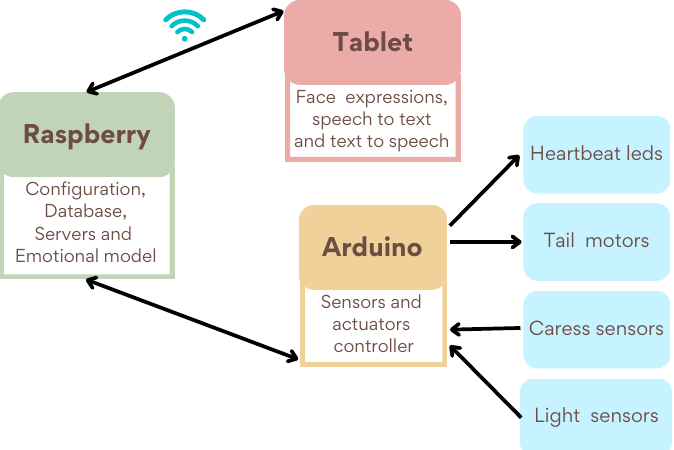
Figure 3. Schematic diagram of the robot hardware involved in the emotional